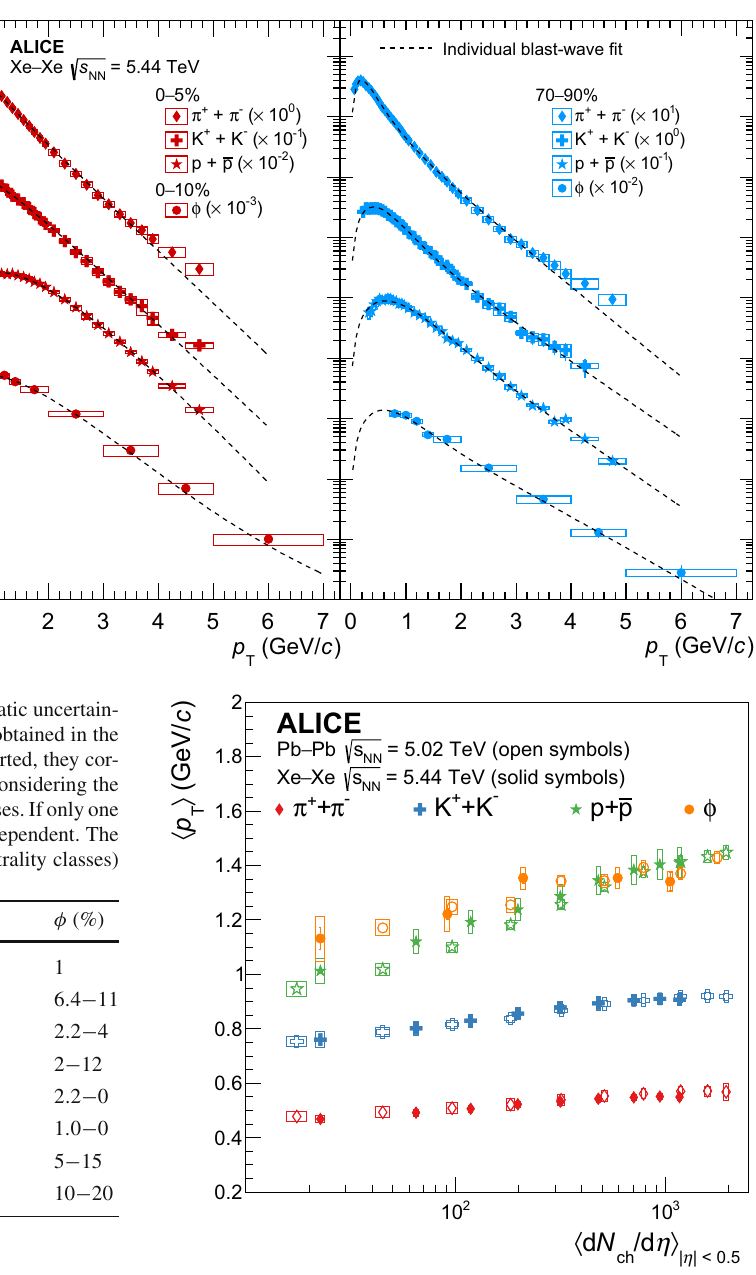
Fig. 3 Mean p T of pions, kaons, (anti-)protons and φ as a function of thecharged-particlemultiplicitydensityinXe–Xecollisionsat 5 . 44 TeV and Pb–Pb collisions at statisticalandsystematicuncertaintiesareshownaserrorbarsandboxes around the data points